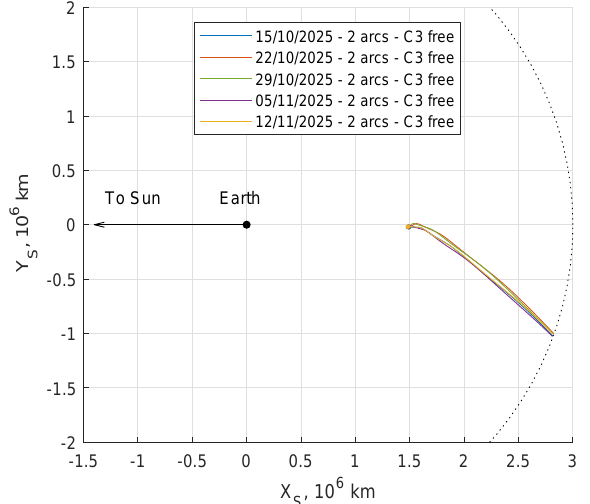
Figure 6. SEL2 case study escape trajectories in the Sun-Earth rotating RF.